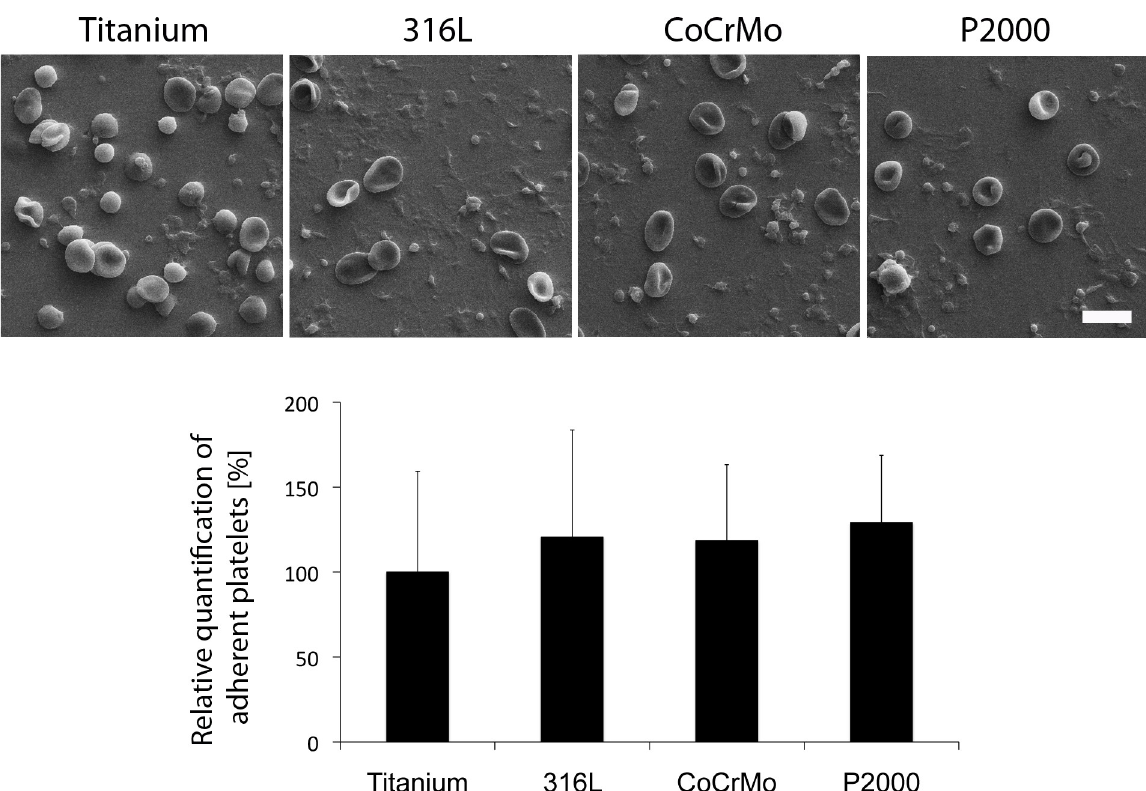
Fig 7. Testing of blood compatibility by platelet adhesion. After 60 min incubation in blood, metal specimens were fixed and analyzed by SEM. Representative images are shown. Data are presented as mean ± S.E.M. Scale bar demonstrates 10 μ m.